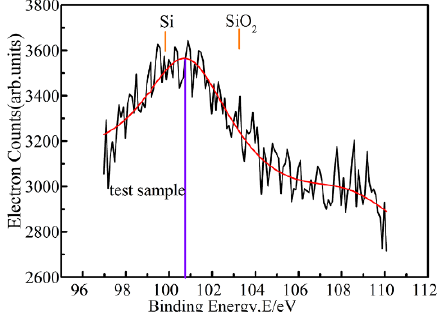
Figure 6. X-ray photoelectron spectroscopy analysis of Si in the inner rust layer of the powder at 120th cycle of the WS0.48Si steel.